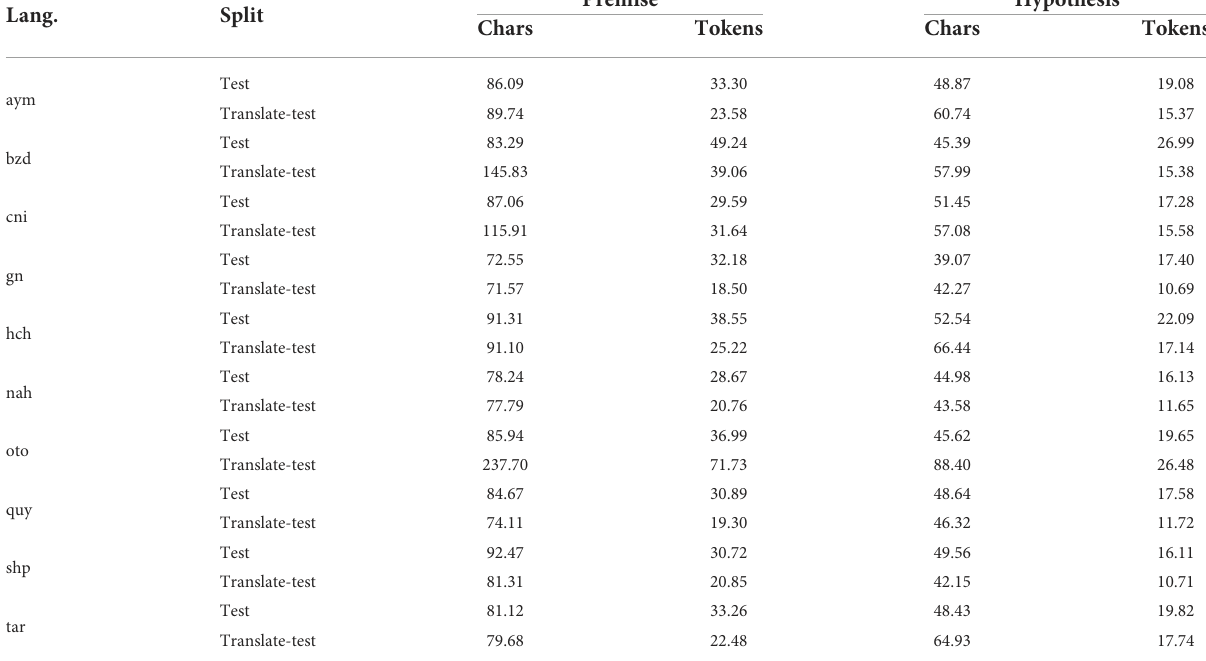
TABLE 7 Average length of an example, in both characters and tokens, for the collected test set as well as the translated test set used for translate-test.